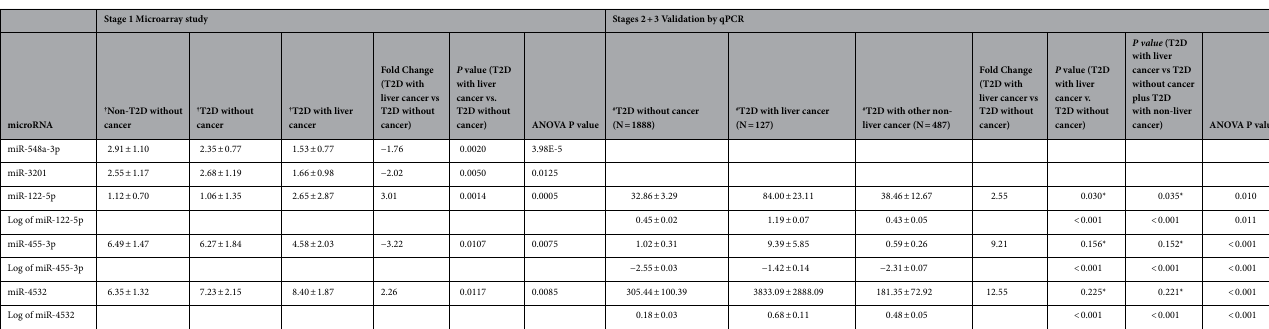
Table 2. List of microRNA showing significant difference in patients with type 2 diabetes and liver cancer. † The expression levels from the microarray study were presented as mean ± standard deviation in log2 scale. # The qPCR data were presented as mean ± standard deviation. *Unpaired t-test with Welch’s correction was used for the